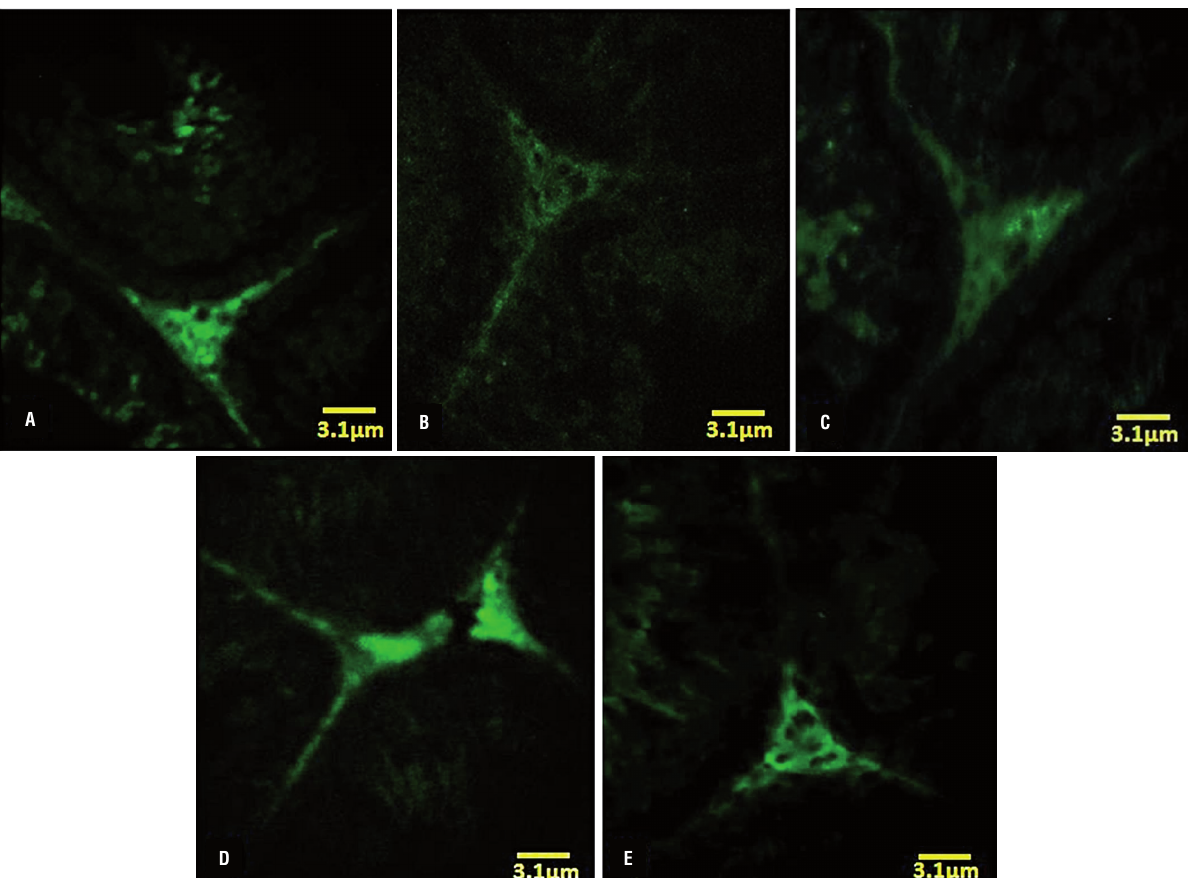
Figure 5 - Fluorescent photomicrograph for leydig cells estroidogenesis. (A) Control-sham group: the leydig cells are marked with intensive intacytoplasmic steroid (arrow), (B) Non-treated VCL group: the leydig cells are presented with faint steroidogenic activity; (C) VitE-received group: the VitE improved the steroidogenic activity of leydig cells versus non-treated VCL-induced testis (arrows); (D) DEX-treated; (E) VityE+DEX-administrated group: note the improved steroidogenesis in these groups, which leydig cells are presented close to normal in control-sham testis. Fluorescent staining for leydig cells steroidogenesis (×400); and (F) Effect of Vit E (150 mg/kg) and DEX (0.125mg/kg) on VCL-decreased percentage of leydig cells with